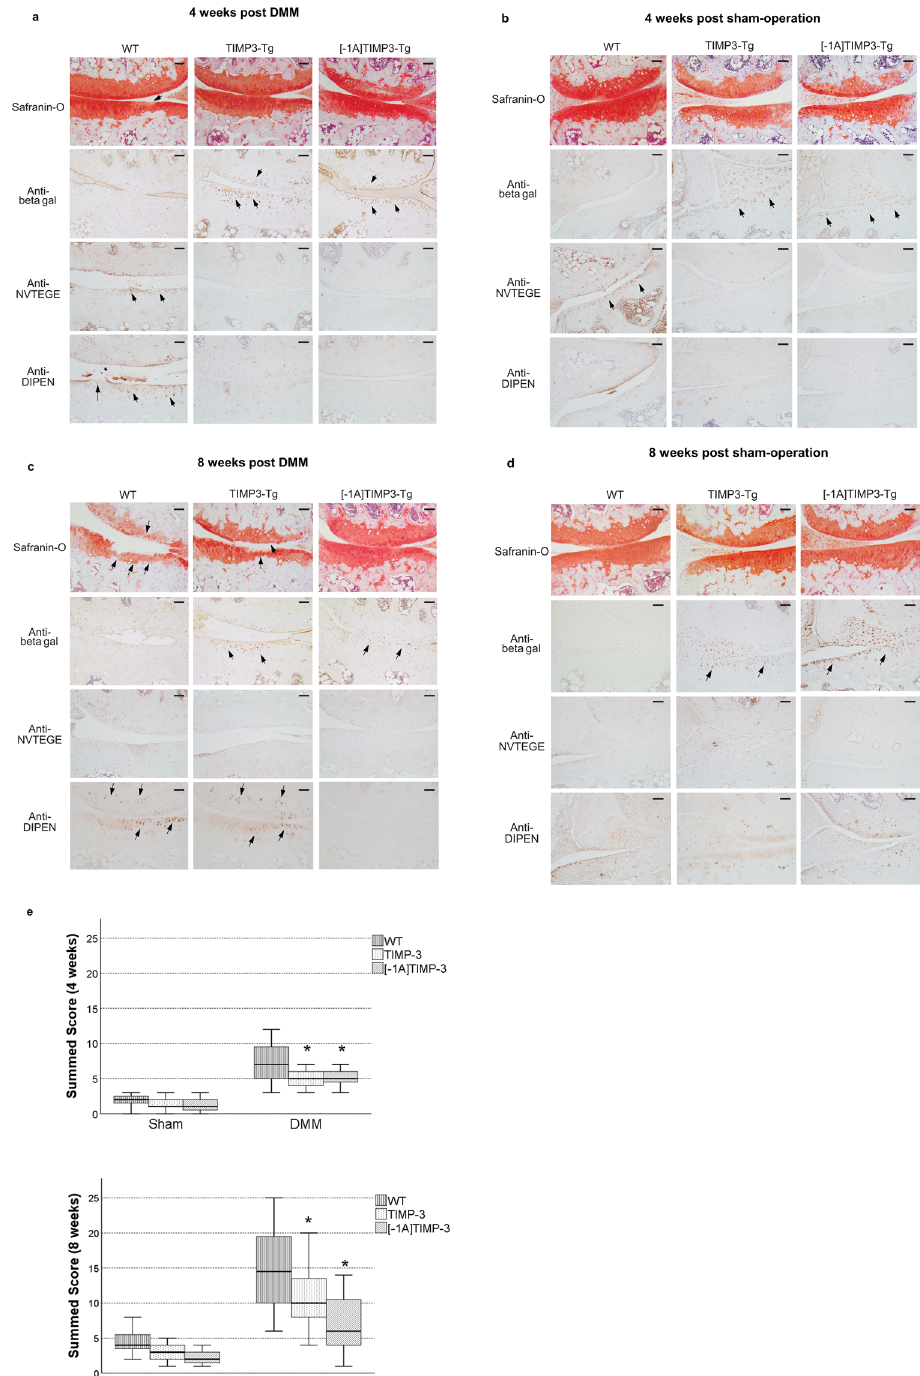
Figure 2. Safranin-O staining and immunostaining of sections of the medial condyle and tibial plateau of non- transgenic mice (WT), TIMP3 heterozygous mice, and [-1A]TIMP3 heterozygous mice 4 weeks after ( a ) DMM or ( b ) sham operation. β -galactosidase nuclear staining was not present in wild-type mice, but strong expression of β -galactosidase was observed in the joints of TIMP3 and [-1A]TIMP3 mice (arrows). Anti-NVTEGE and anti-DIPEN immunostaining of adjacent joint sections showed that wild-type cartilage demonstrated cleavage of aggrecan in the cartilage of the femoral condyle and tibial plateau (arrows). Bars, 50 μ m. Safranin-O staining and immunostaining of sections of the medial condyle and tibial plateau of non-transgenic mice (WT), TIMP3 heterozygous mice, and [-1A]TIMP3 heterozygous mice 8 weeks after ( c ) DMM or (d ) sham operation. No β -galactosidase staining was performed for the wild-type mice. The expression of β -galactosidase in the joints of TIMP3 and [-1A]TIMP3 mice indicate upregulated transcription of TIMP3 and [-1A]TIMP3. DIPEN immunostaining of adjacent joint sections showed that non-transgenic mice demonstrated cleavage of aggrecan in the cartilage of the tibial plateau and meniscus compared with the same areas in TIMP3 and